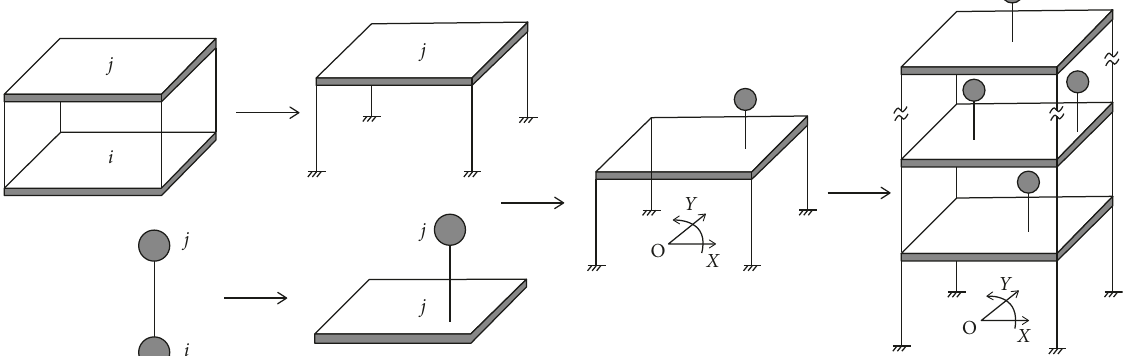
Figure 2: Establishment of spatial dynamic model of primary-secondary coupled system.